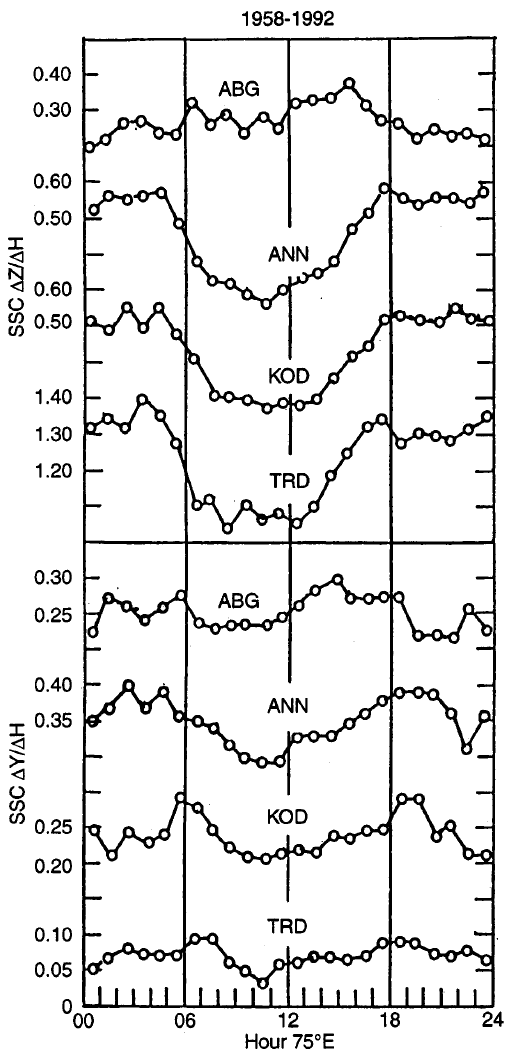
Fig. 5. Solar daily variations of the ratios of SSC amplitudes j D Y = D H j and j D Z = D H j averaged over 1958–1992 at TRD , KOD , ANN and